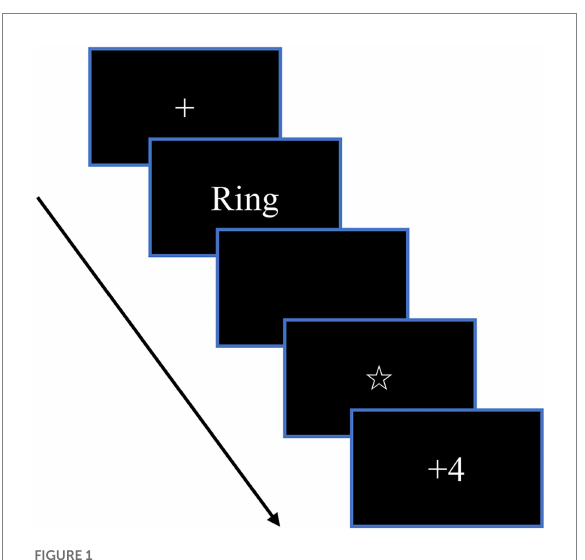
FIGURE 1 Task structure, Feedback Concealed Information